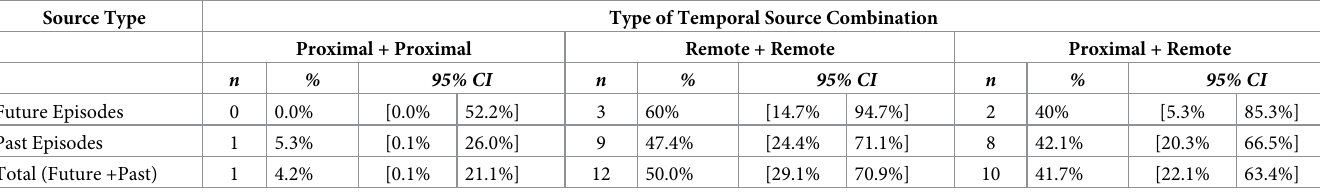
Table 4. Combinations of episodic sources from different